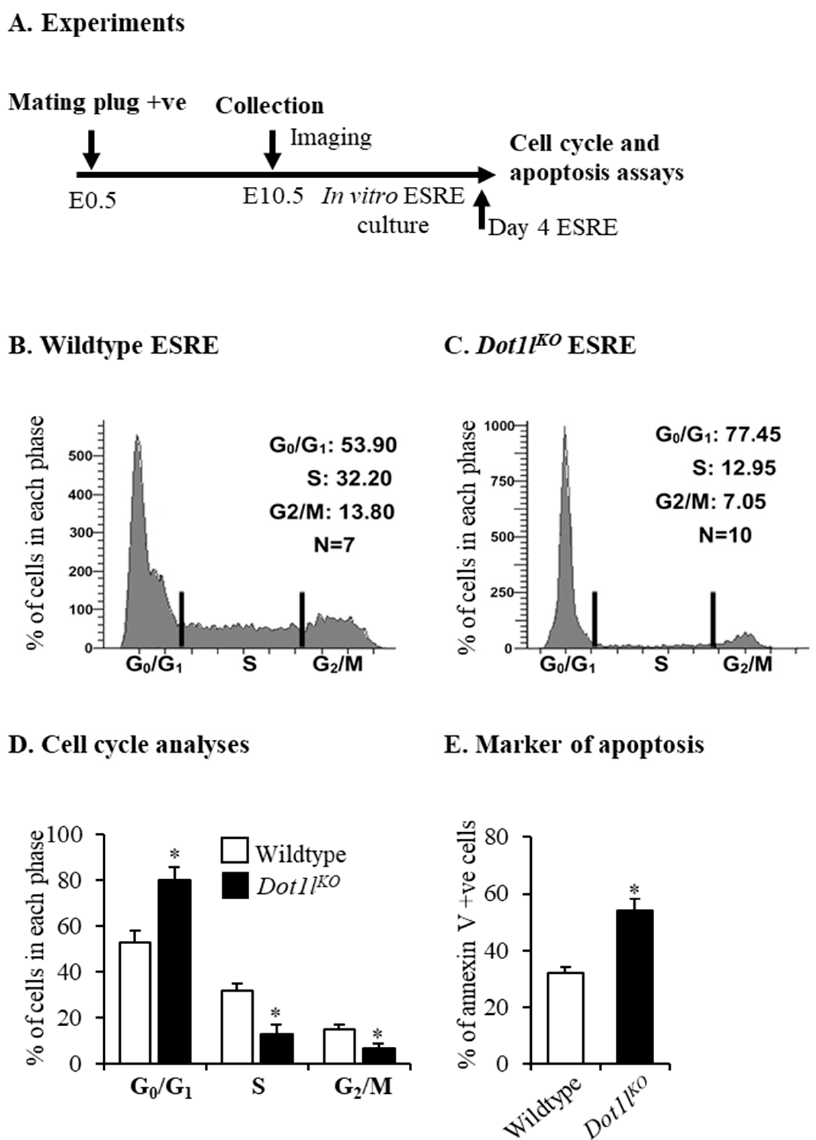
Figure 2. Dot1l KO progenitors underwent cell cycle arrest during in vitro erythroblast culture. ( A ) Schematic diagram showing the studies for cell cycle progression and apoptosis analysis. On day 4 of culture, cells were collected, fixed, and either stained with propidium iodide for cell cycle analyses or labeled with annexin V for signs of apoptosis. A large number of erythroid progenitors from Dot1l KO yolk sacs displayed G 0 /G 1 arrest ( B – D ). In addition, an increased percentage of Dot1l KO erythroid progenitors were found to be annexin V positive ( E ). Data are expressed as the mean ± SE; n > 6; * p < 0.05.